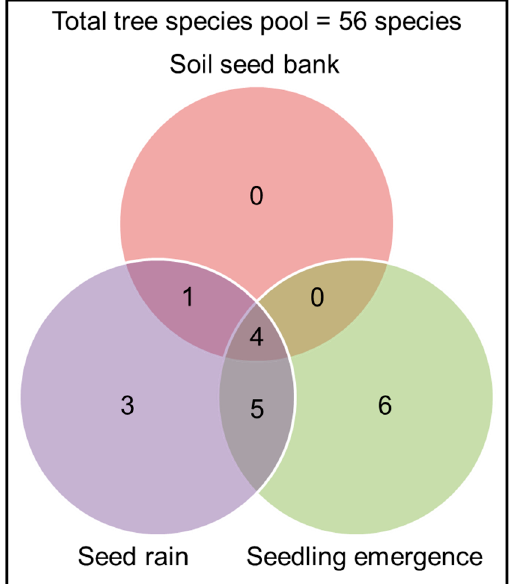
Figure 4. Number of tree species detected from the seed rain, soil seed bank, and seedling emergence experiment and total number of tree species in current standing vegetation (56 species).